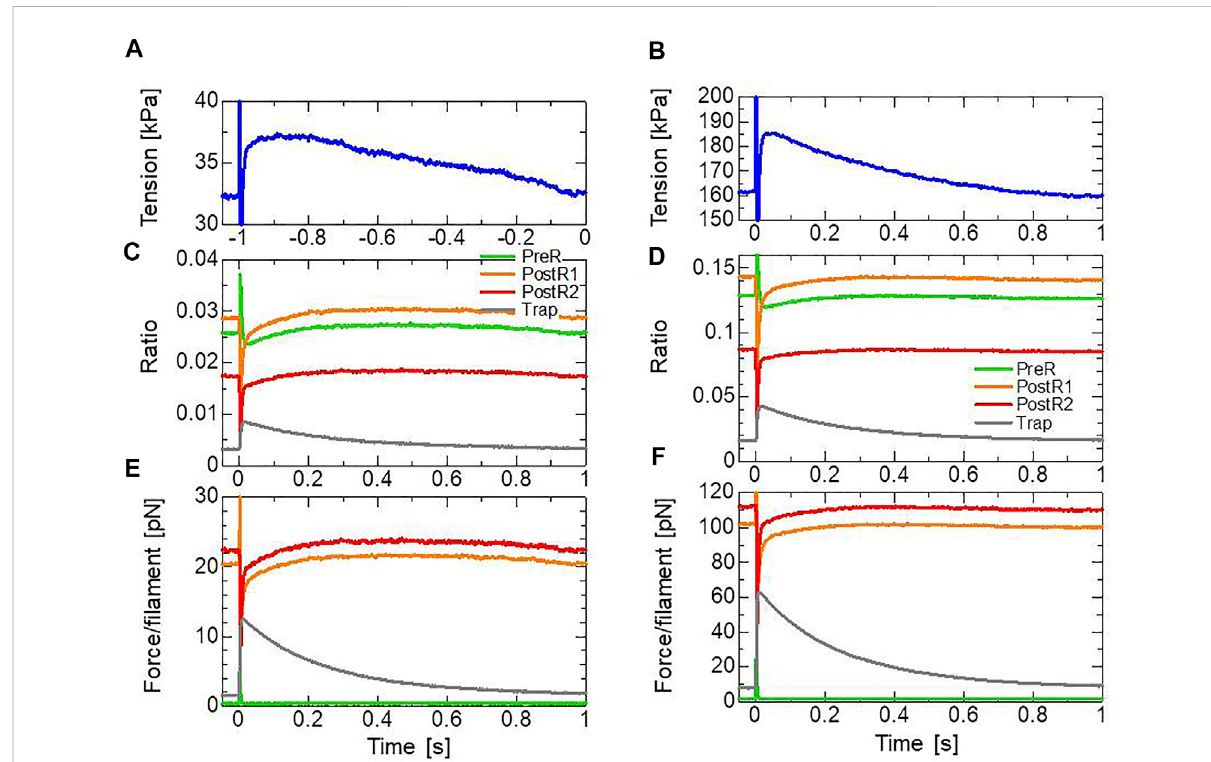
FIGURE 9 Transients of the four attached states during and after the 1-ms stretching in the stretch activation test with [Ca 2+ ] = 0.3 μ m (left) and [Ca 2+ ] = 0.4 μ m (right). (A,B) Time courses of the tension for a 7-nm stretch. (C,D) Time courses of the populationratio of the attached states: XB PreR